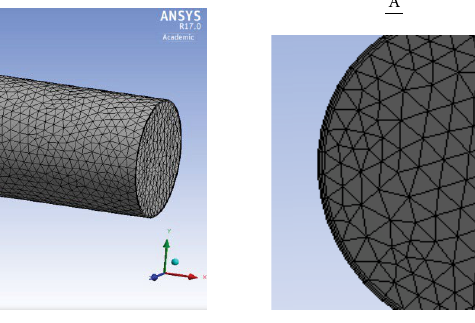
Figure 2. The volume calculation